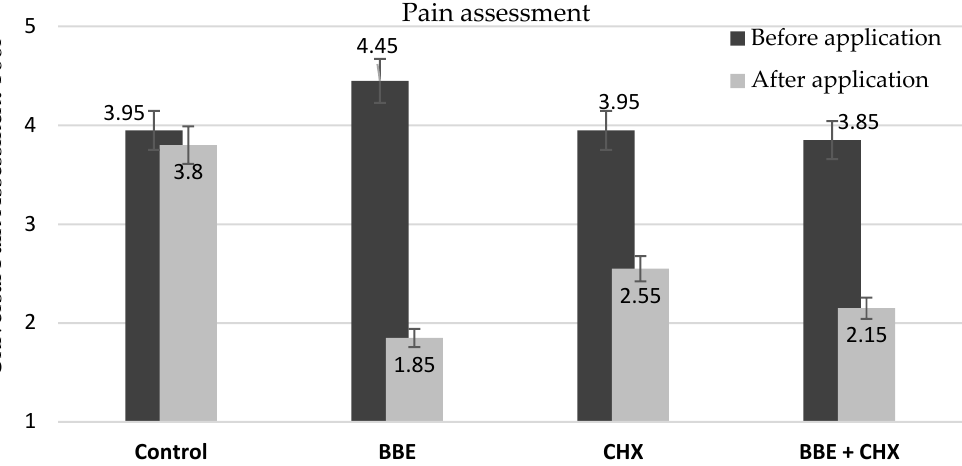
Figure 3. The chart representing the pain assessment values before and after the application of tested solutions. Control—patients treated with saline solution; BBE—patients treated with beech bark extract; CHX—patients treated with chlorhexidine; BBE + CHX—patients treated with beech bark extract and a chlorhexidine (ratio 1:1).